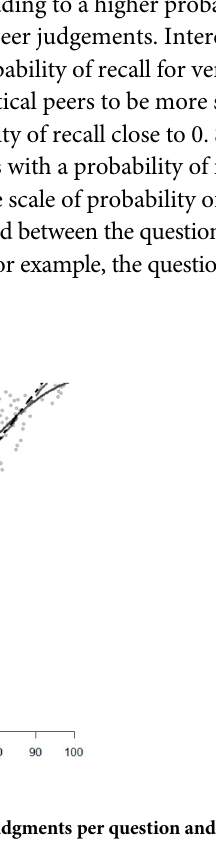
Fig 7. Relationship between the mean peer judgments per question and the probability of recall modelled with linear and polynomial regression. Each dot represents one question. Regression models are